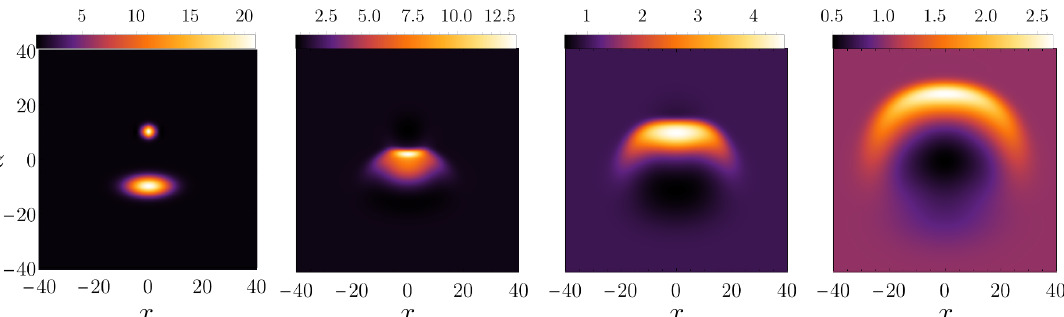
Figure 4 . Mass density at the collision plane at t = (0 , 3 , 7 , 13) . The collision corresponds to the unequal blob collision from table